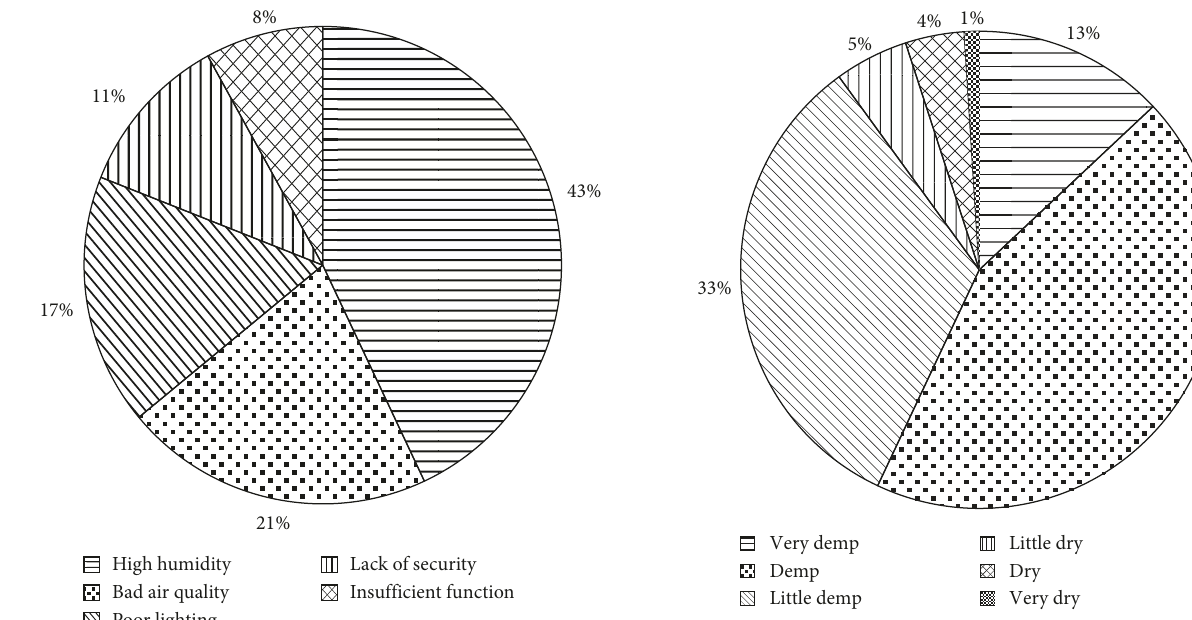
Figure 1: The statistical survey data of the main disadvantages of cave dwelling.